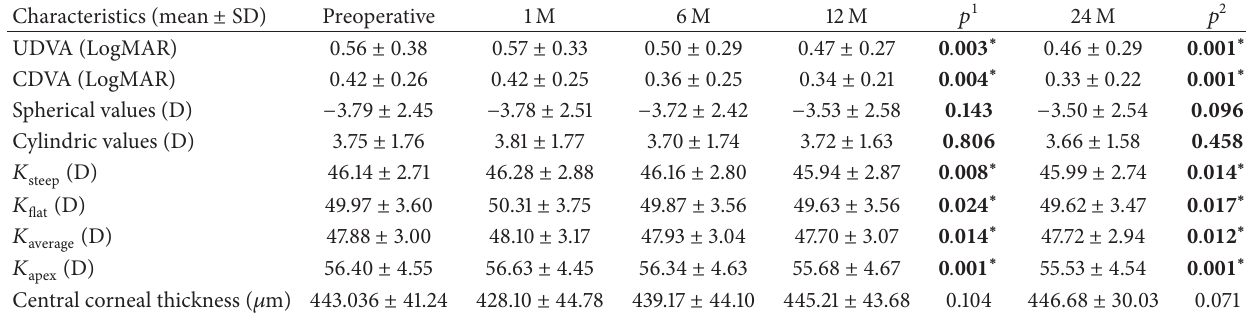
Table 1: Visual, refractive, and corneal topography data before and 1, 6, 12, and 24 months after accelerated corneal cross-linking.